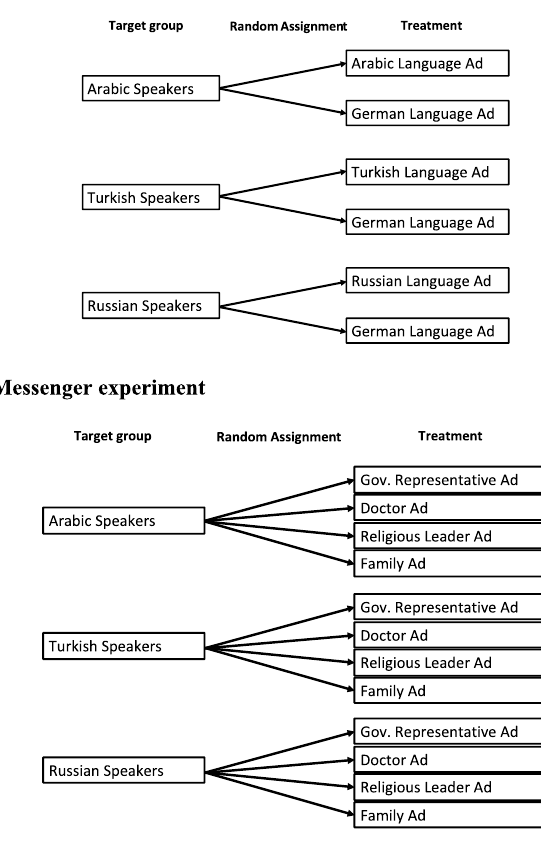
Figure 1. Experimental design. Note : Samples were first collected in Berlin (November 2021) and then scaled up to all of Germany (December 2021). For the Berlin sample, only the Arabic speakers were